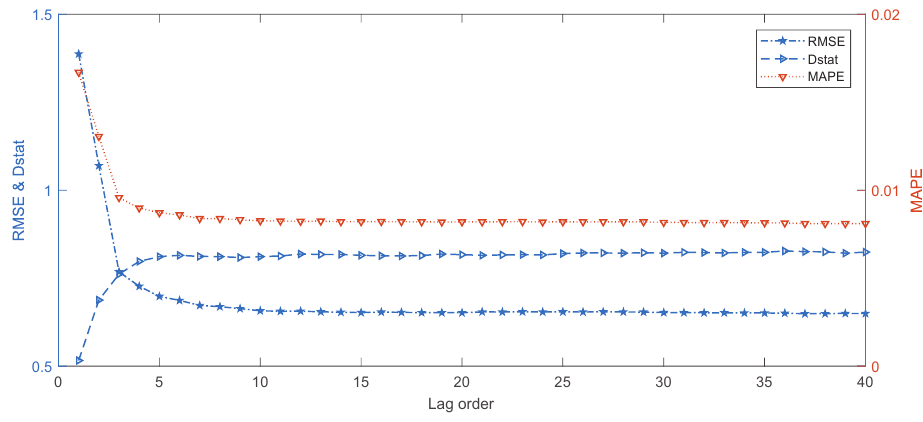
Figure 4. The impact of lag on WTI crude oil prices with one-step-ahead